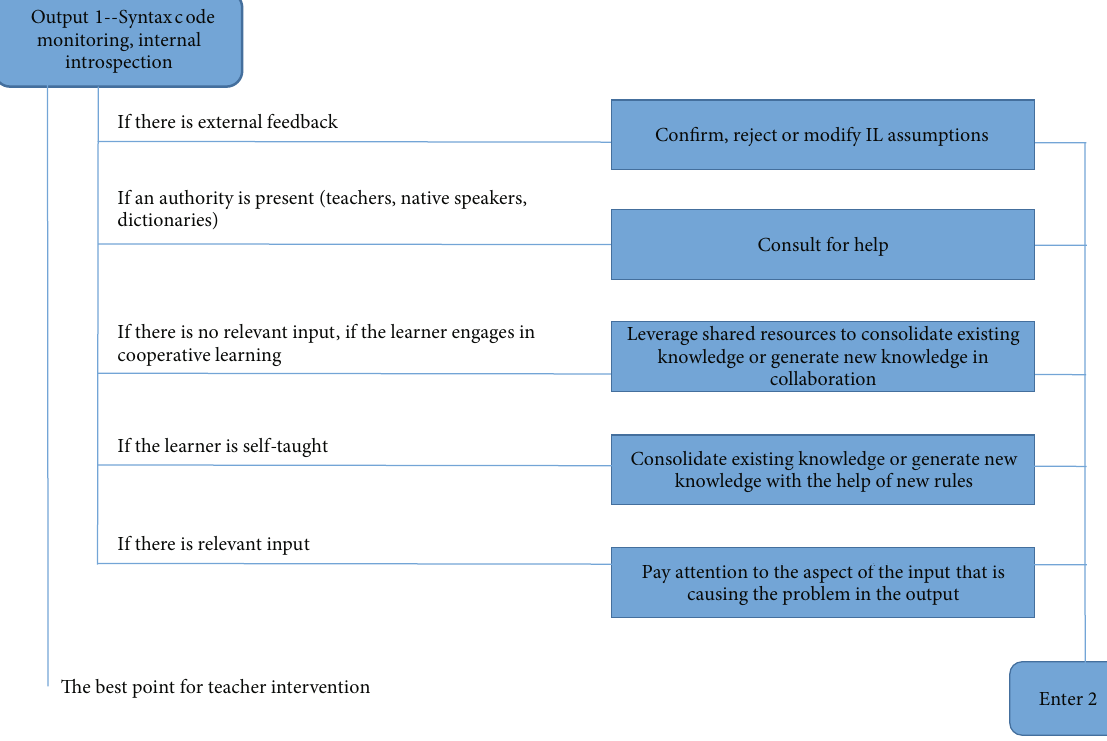
Figure 9: The mechanism of input-output hypothesis in English classroom.